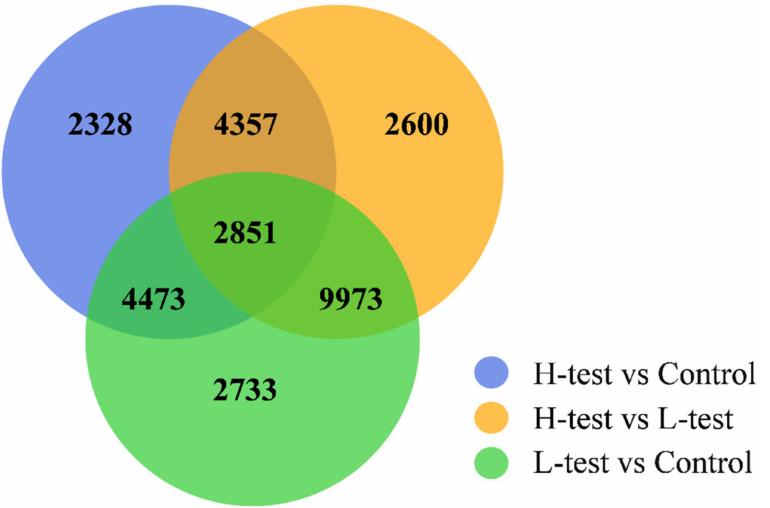
Figure 4. Venn diagram of differentially expressed gene in the liver transcriptome of H. erectus